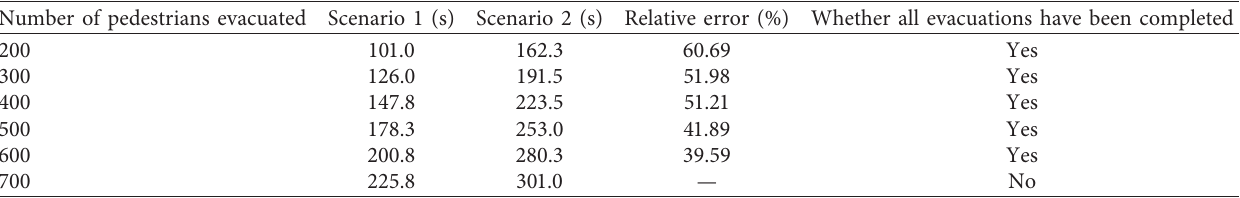
Table 9: Pedestrians evacuation in two scenarios.